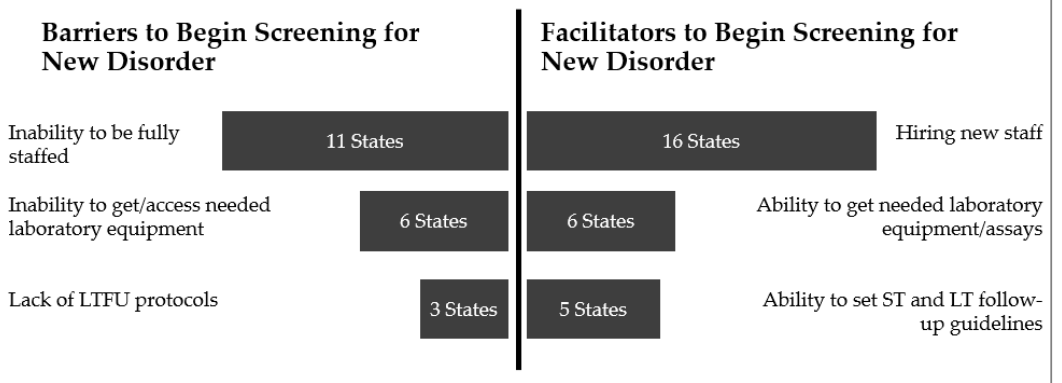
Figure 2. Factors Identified as both Barriers and Facilitators to Implementation of Statewide Newborn Screening of a New Disorder, Collected from Grantee Progress Reports and Interviews.